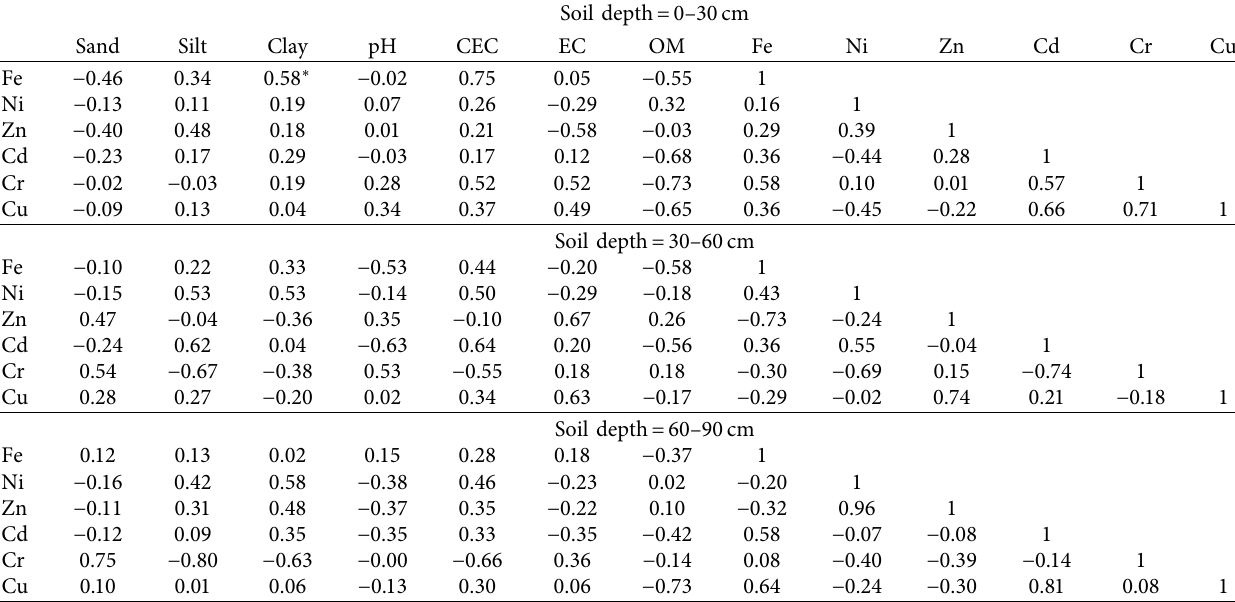
Table 2: Correlation coefficient between soil properties and heavy metals at different